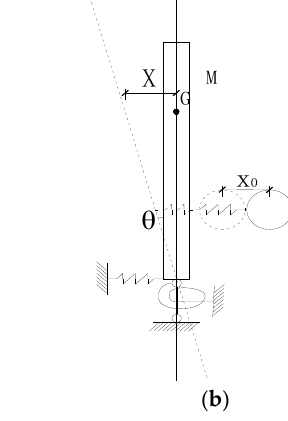
Figure 7. Mechanical model: ( a ) Geometric parameters; ( b ) Motion parameters.